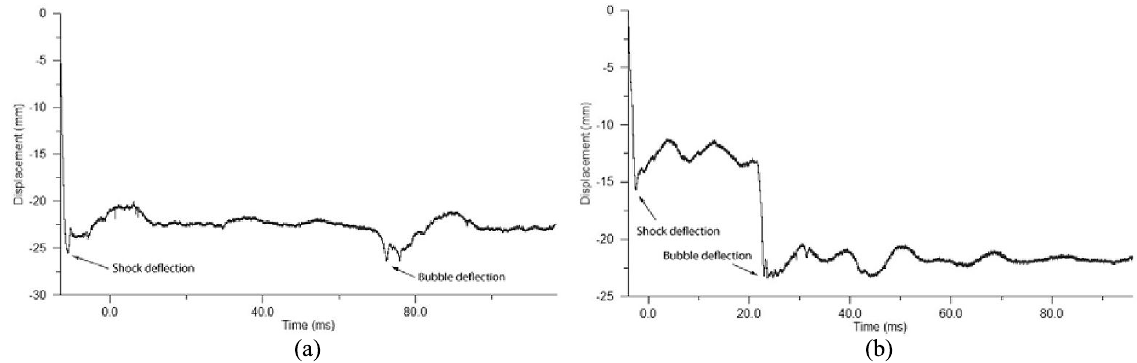
Fig. 4. Dynamic mid-point deflection histories: a) shock-dominated deflection, b) deflection from both shock and bubble collapse.